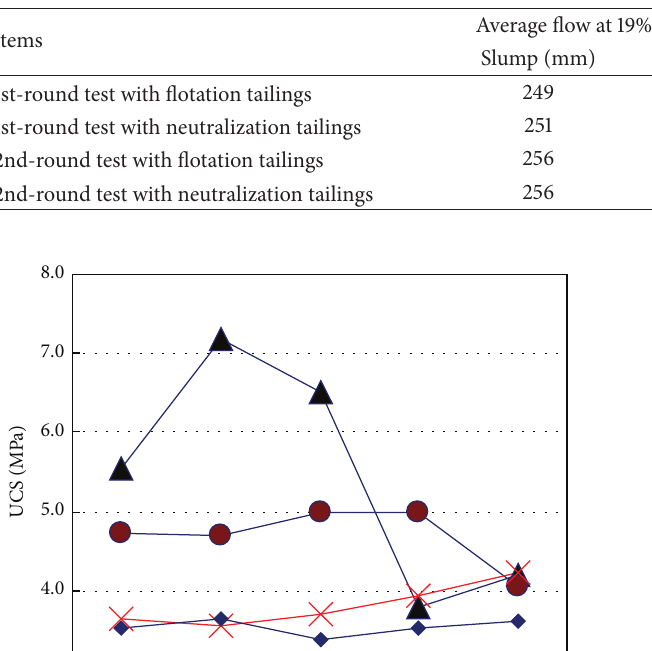
Table 5: Comparison of backfill slurry flow behavior.